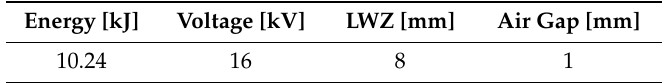
Figure 2. The processing window applied for welding in this study (adapted from [18]). Table 4. Welding parameters applied in this study that were kept constant [17].